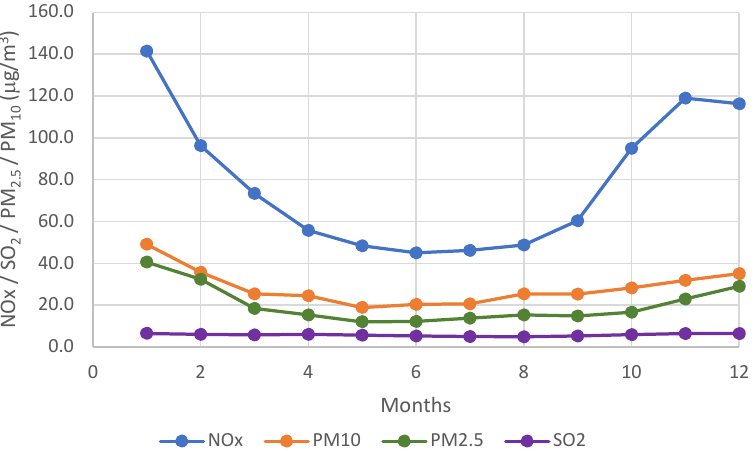
Figure 6. Variation of the multiannual monthly average per pollutant.